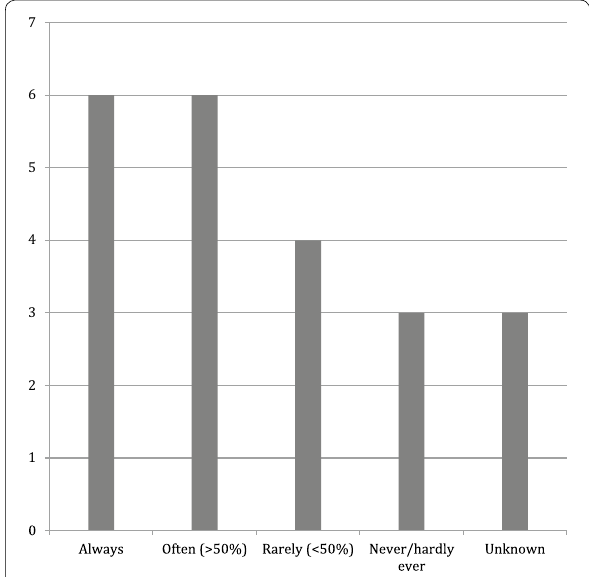
Fig. 4 Ultrasonography usage according to trauma leaders. Usage according to trauma leaders when asked how frequently ultrasonog- raphy is used in trauma care in their facility and number of